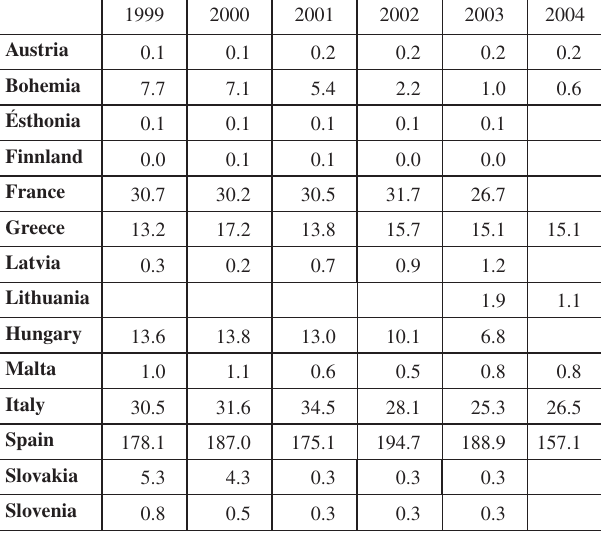
Table 1. The harvested quantity of the garlic in the EU countries